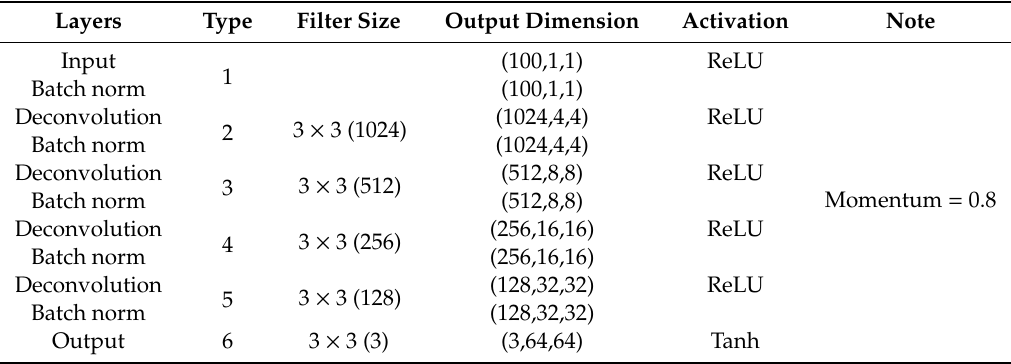
Table 2. Detailed architecture for the generator.